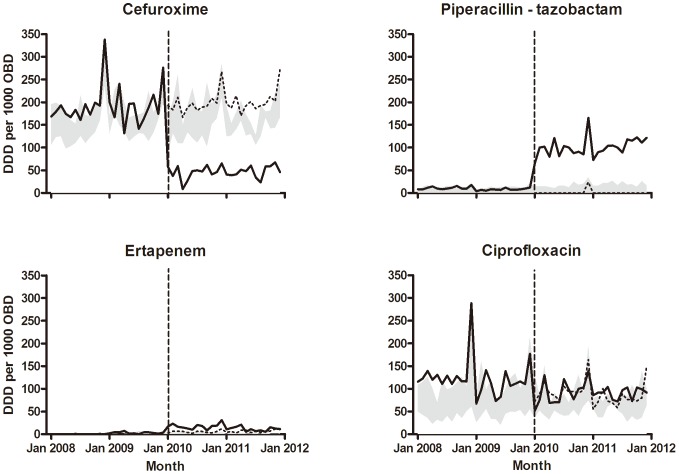
Monthly consumption of antimicrobials.Bold lines show the monthly consumption at the intervention hospital. Dashed lines represent the predicted usage. Grey shaded bands illustrate the range of the monthly use at the four control hospitals. DDD = defined daily doses; OBD = occupied bed-days. The consumption of ciprofloxacin did not changed significantly, but shifts in levels of consumptions of cefuroxime (p<0.001), ertapenem (p = 0.001), and piperacillin-tazobactam (p<0.001) at the intervention hospital were statistically significant, as indicated by segmented regression analysis of interrupted time series.